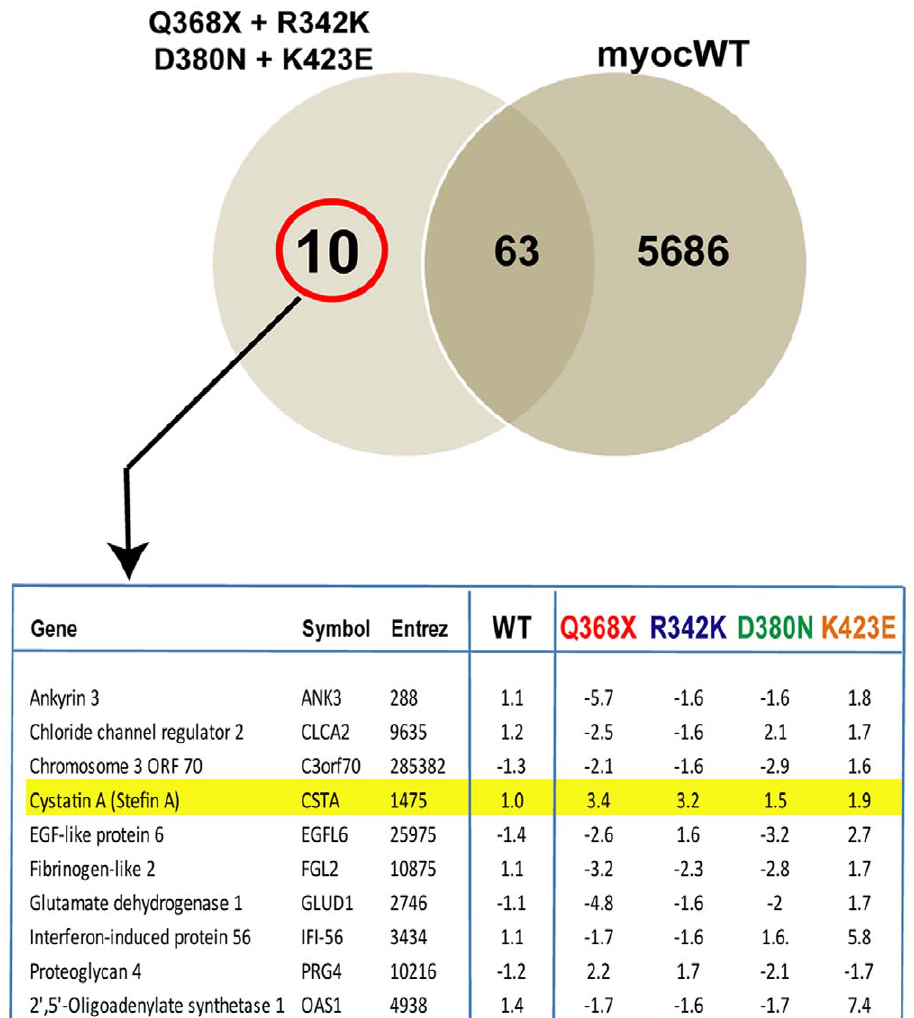
Figure 8. Cystatin A is induced in all MYOC mutants and not in MYOC wild-type. Top : Venn diagram comparing genes altered 1.5-fold in all MYOC mutants (left circle) with those altered in the MYOC wild-type (right circle) (from Figure 6). Intersection indicates numbers of altered genes which are shared between all the mutants and those altered in the wild-type. Number of genes specifically altered by the mutants is outside the intersection and circled in red. Bottom : list of specific genes highlighting Cystatin A and its altered fold change values in each